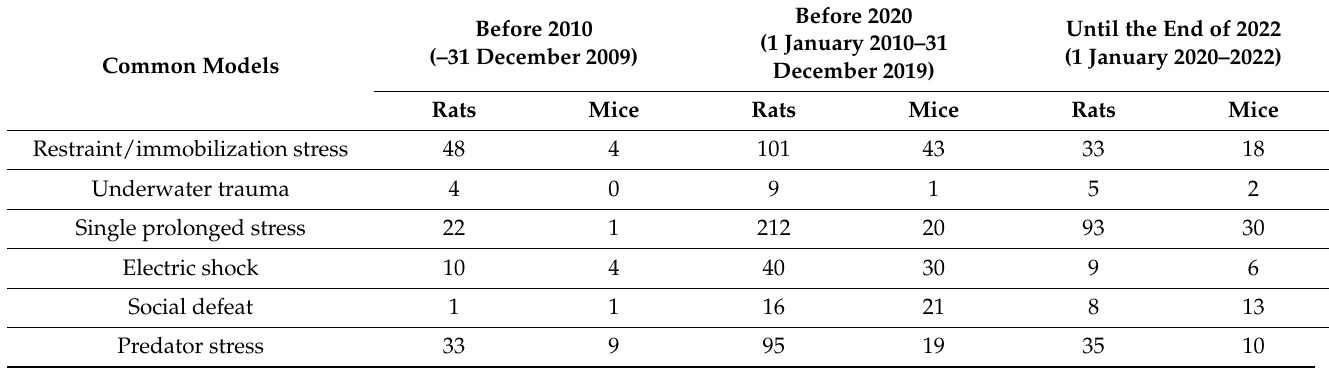
Table 1. The common paradigms and the number of studies per each paradigm in rodent PTSD studies.